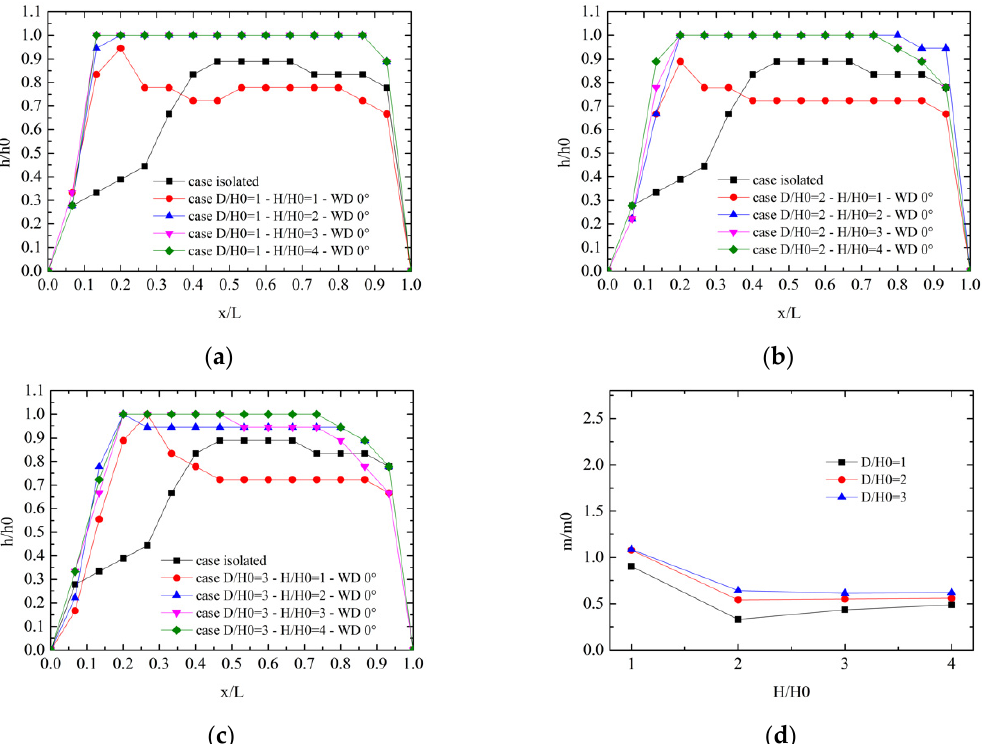
Figure 5. Experiment results of cases under the 0° wind direction: ( a ) building spacing: D / H 0 = 1; ( b ) building spacing: D / H 0 = 2; ( c ) building spacing: D / H 0 = 3; ( d ) normalized mass of particles blown off the target building.